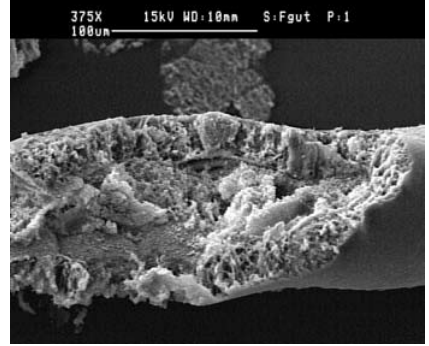
Fig. 6. scanning electron micrograph of the foregut/ midgut of a fourth-instar larva longitudinal section.